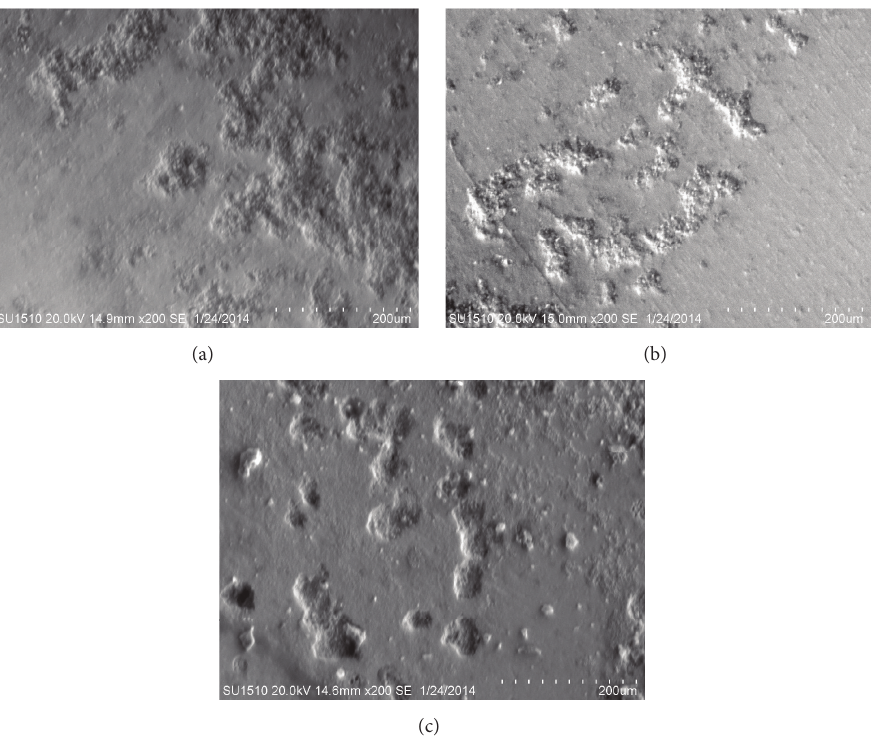
Figure 14: Superficial aspects of NdPr magnets after corrosion tests for 24 hours in 3.5% NaCl solution at 25 ∘ C: (a) 30Nd6Pr, (b) 30Nd8Pr, and (c)